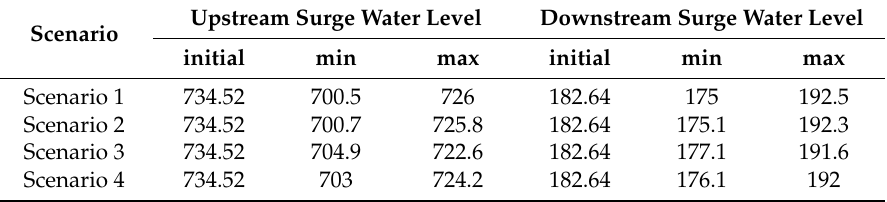
Table 10. The index values of 15 schemes by different scenarios (II). Figure 11. The Pareto front obtained of EMOBCGSA by different scenarios under pump outage conditions. Table 8. The detailed Pareto optimal schemes obtained of EMOBCGSA by different scenarios under pump outage conditions.